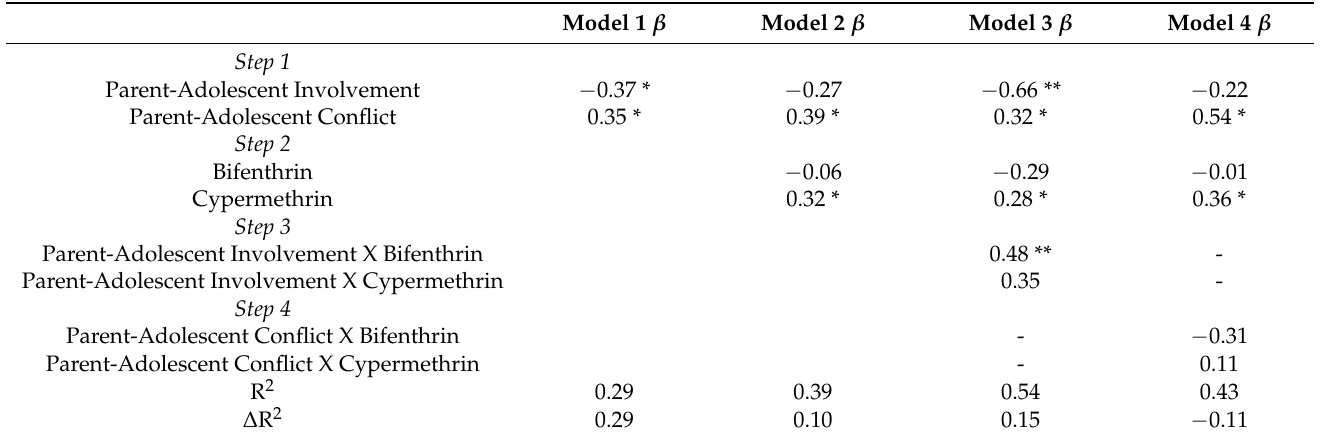
Table 2. Ordinary least squares standardized regression results from models of the number of adolescent depressive